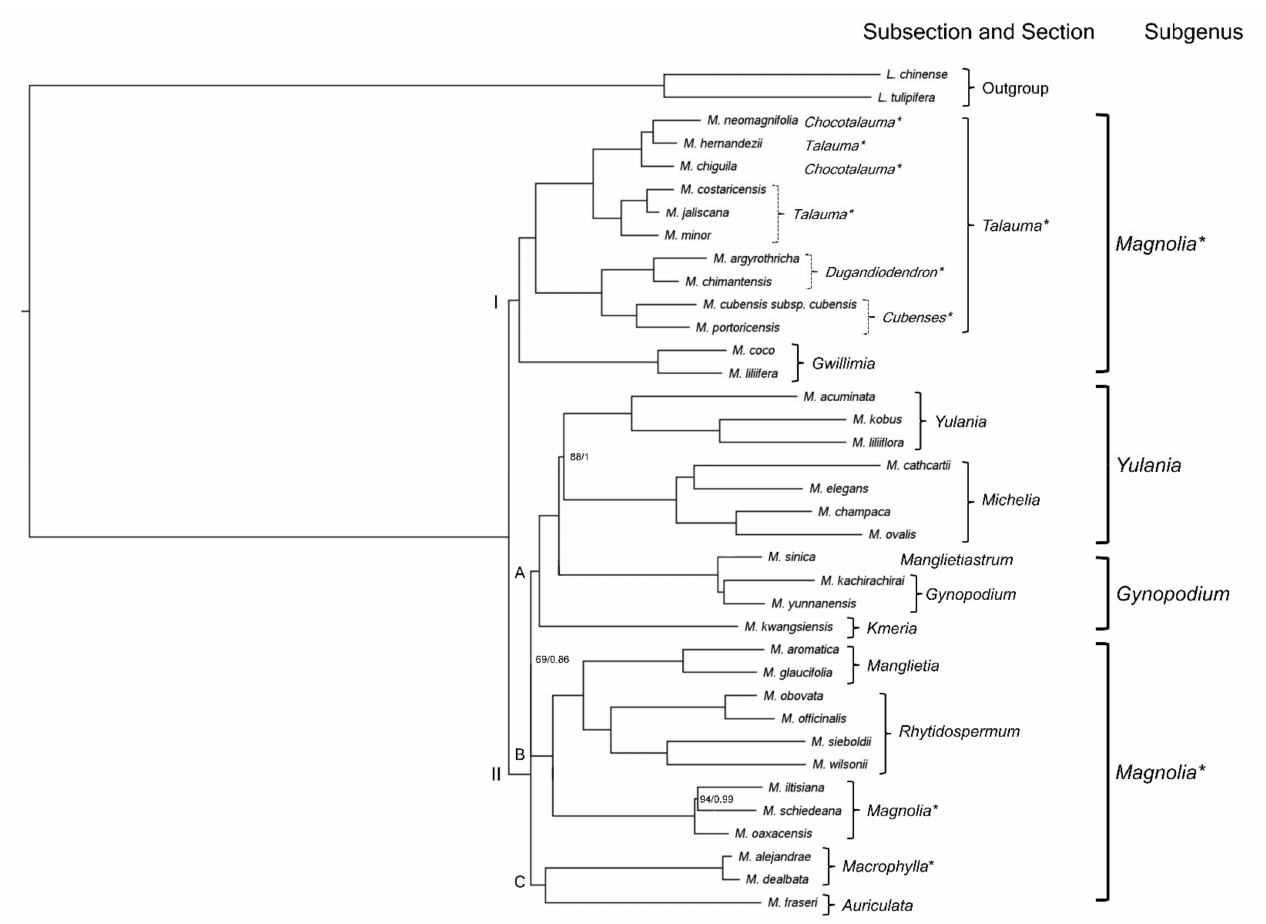
Figure 4. Phylogenetic relationships obtained from the Bayesian inference analysis of the newly assembled plastomes from 15 Neotropical species plus 22 plastomes downloaded from the NCBI; Liriodendron was used as an outgroup. The classification was according to [51,60]; The Neotropical subsections are shown in dotted brackets. The numbers at the nodes represent the ML bootstrap and BI posterior probability support values, respectively; nodes without numbers correspond to 100/1 support values. * = Neotropical